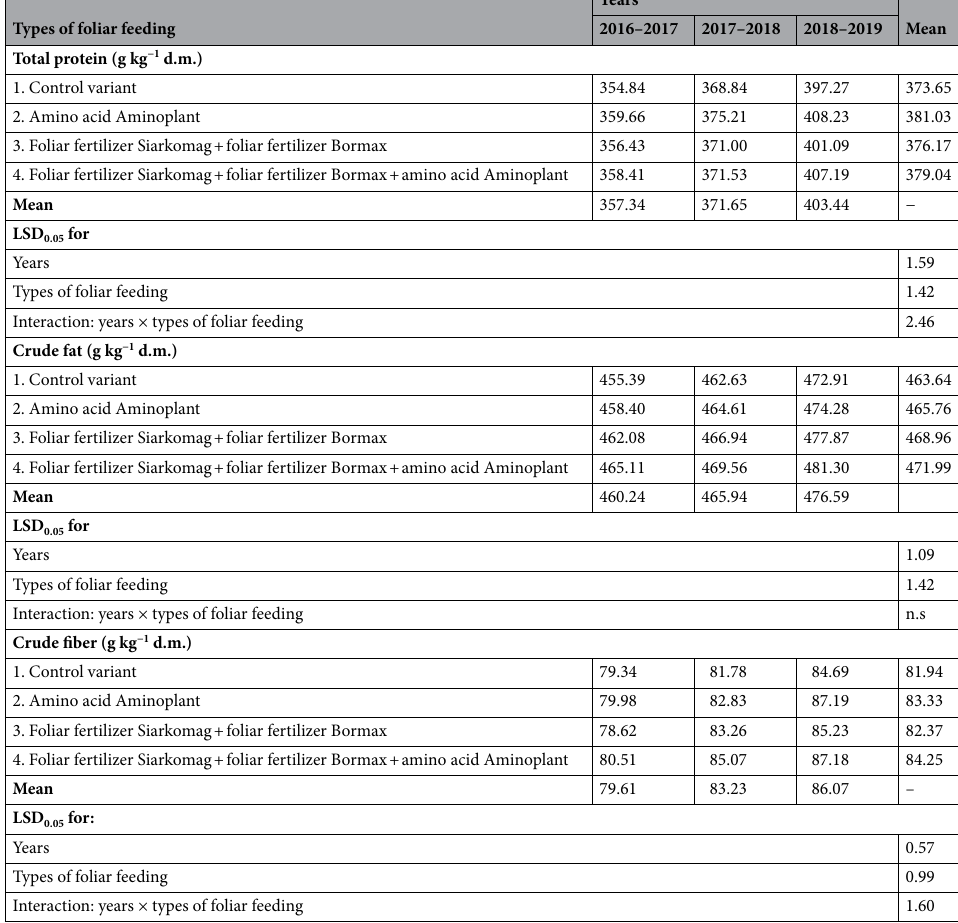
Table 4. Chemical composition of rapeseed depending on climatic conditions in the years of the study and types of foliar nutrition. d.m. dray matter, n.s. not